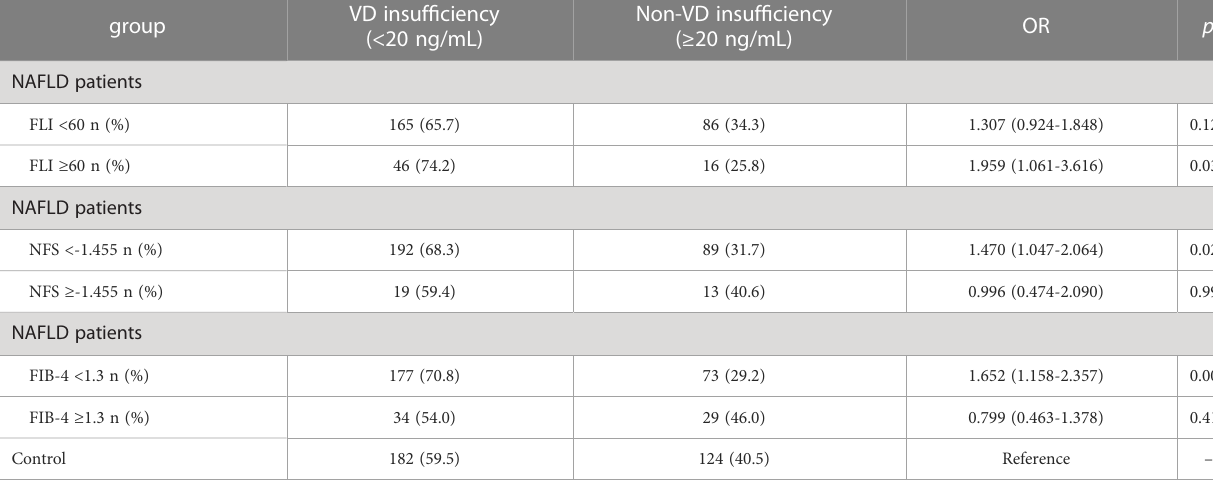
TABLE 4 Association between vitamin D insuf fi ciency and liver fi brosis index of NAFLD patients and controls.